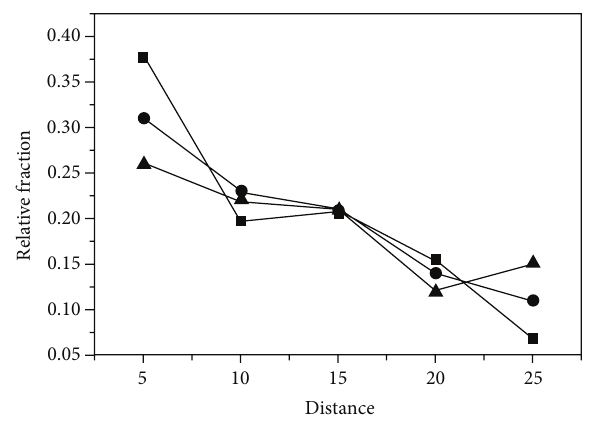
Figure 7: The relative fraction of AR of different areas as a function of distance from CH (circles are all AR, squares are groups of areas more than 100msh, and triangles are groups of areas less than